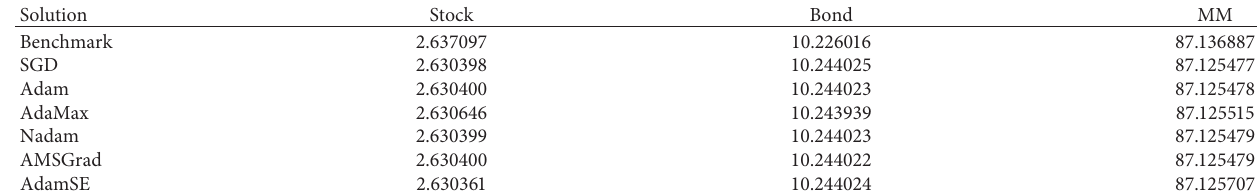
Table 2: Optimal portfolio